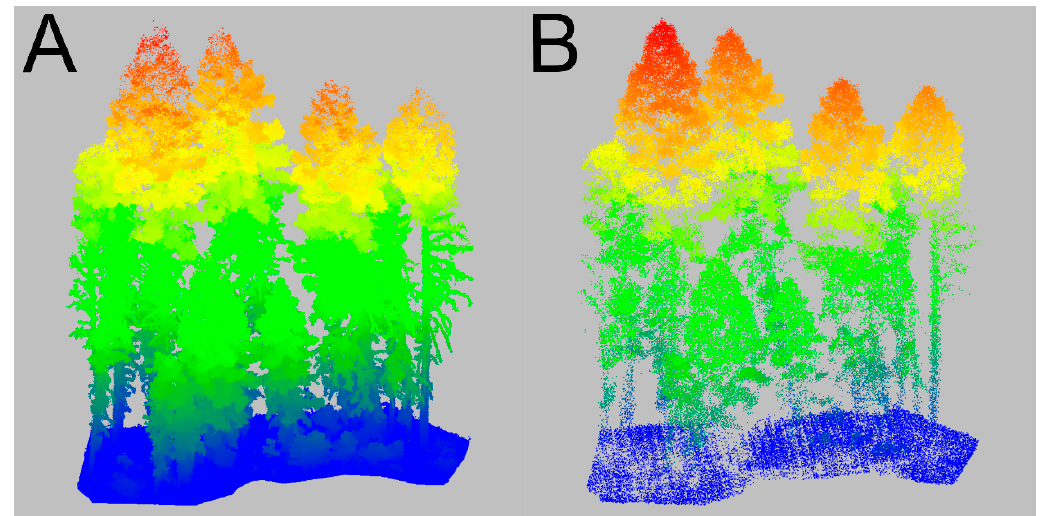
Figure 2. Examples of the two types of point clouds from ( A ) mobile laser scanning (MLS) and ( B ) remotely piloted aerial systems (RPAS) LiDAR.